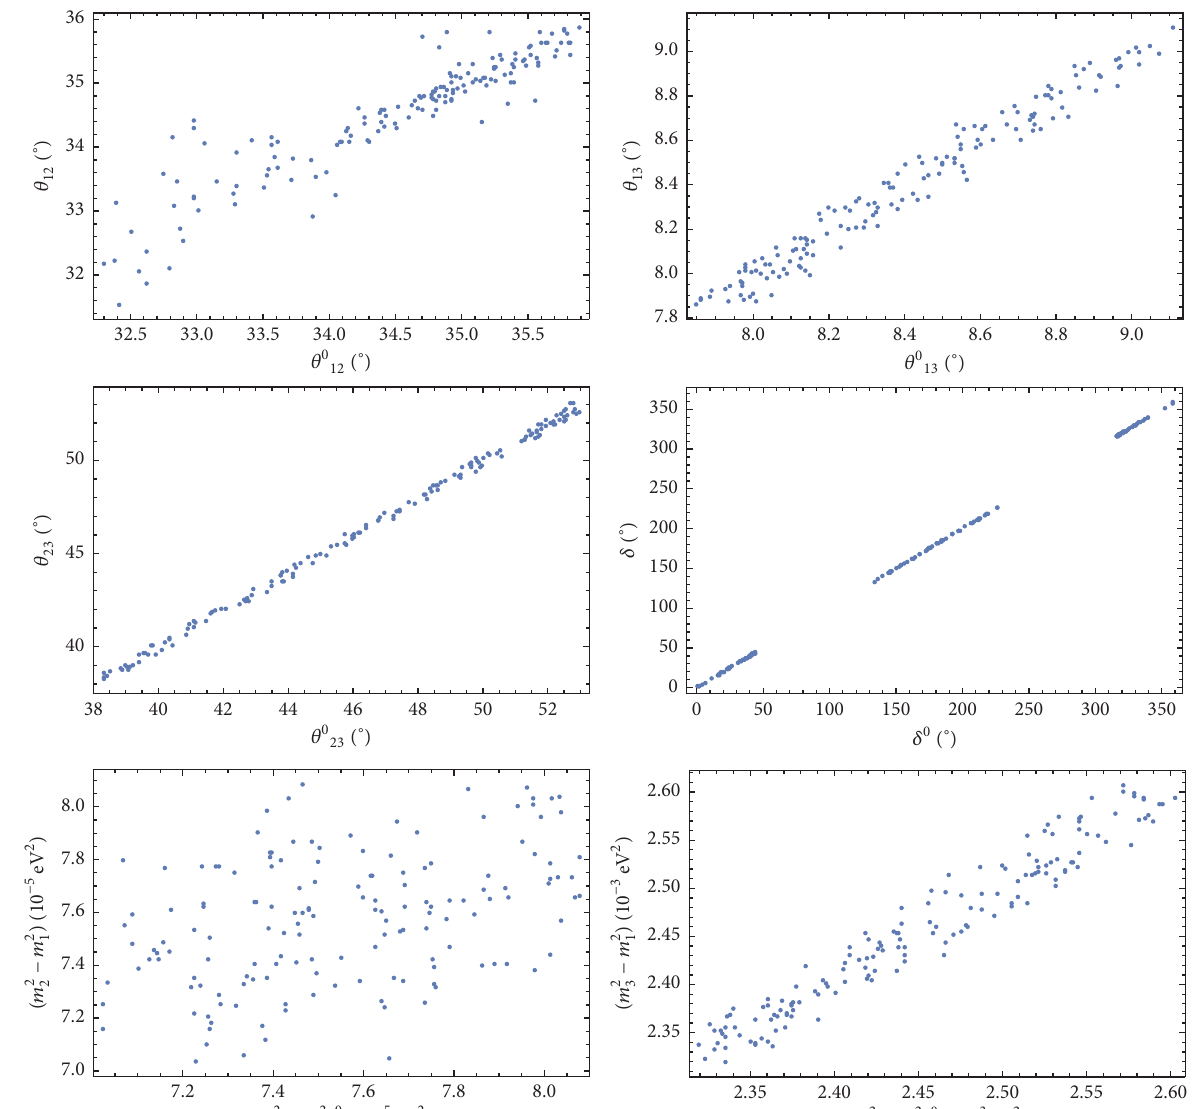
Figure 5: Correlations of neutrinos oscillation parameters before and after the perturbation with the parameter 𝜖 3 .